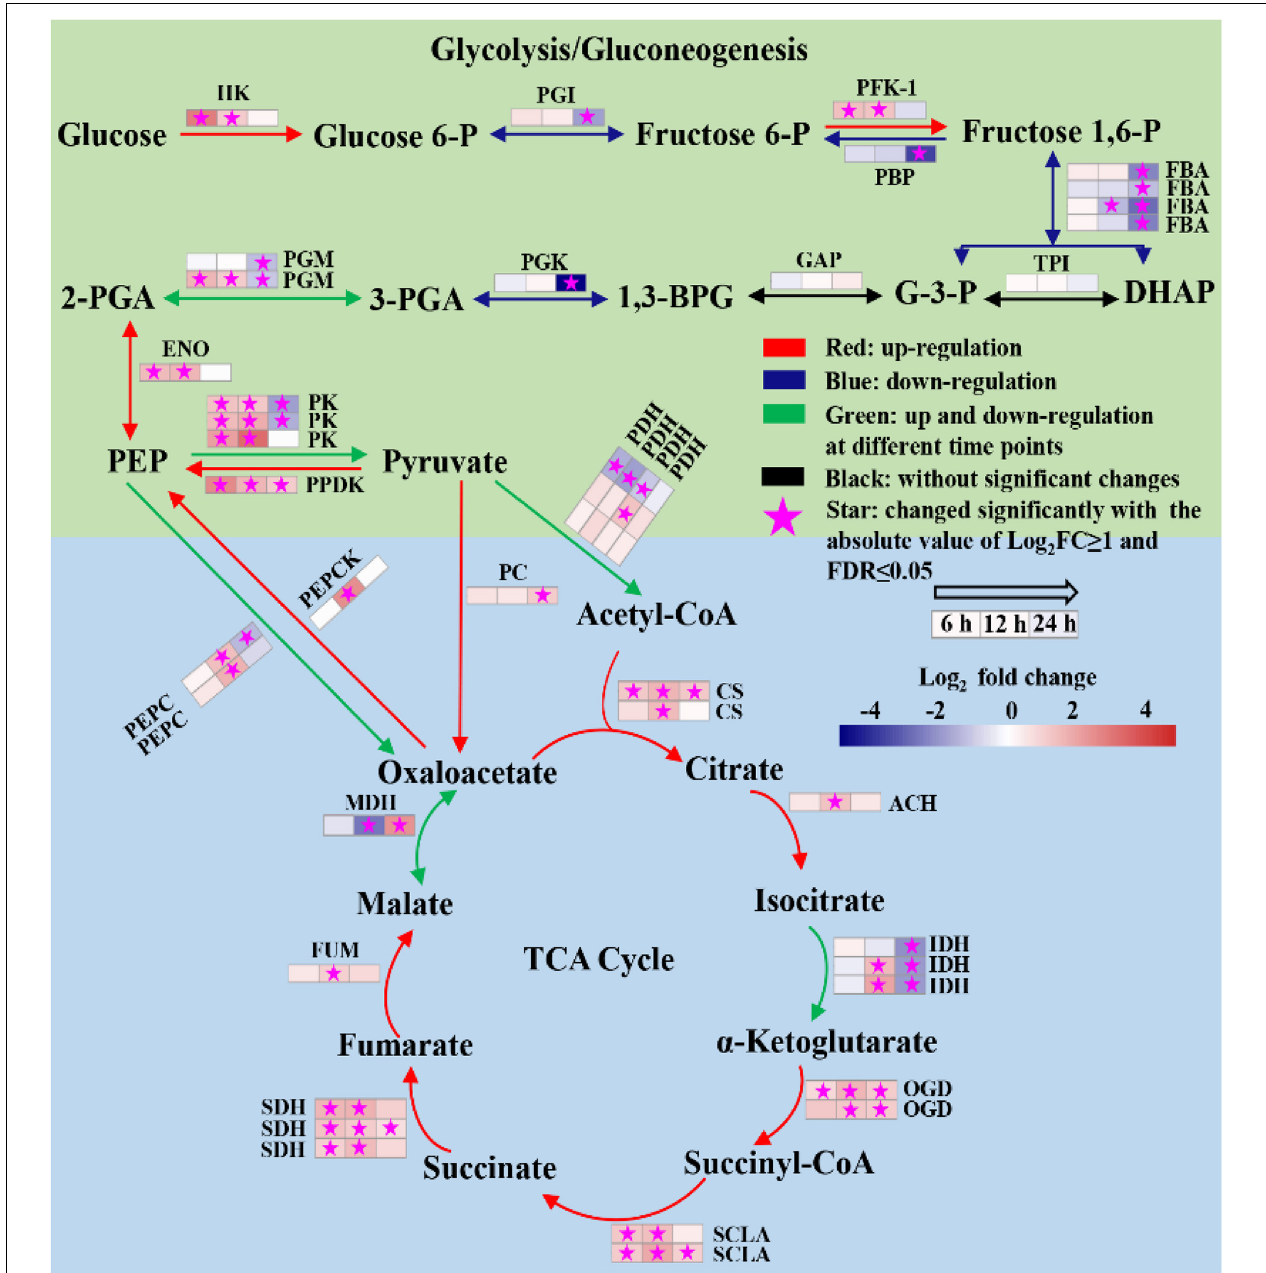
FIGURE 6 | Reconstructed glycolysis/gluconeogenesis and TCA cycle of heterotrophically grown S. acuminatus cells subjected to the high-light and N-limited conditions. Genes upregulated were indicated in red. Genes downregulated were indicated in blue. Genes upregulated and downregulated at different time points were indicated in green. No significant changes were indicated in black. The full names of the corresponding genes are given in Supplementary Table 6